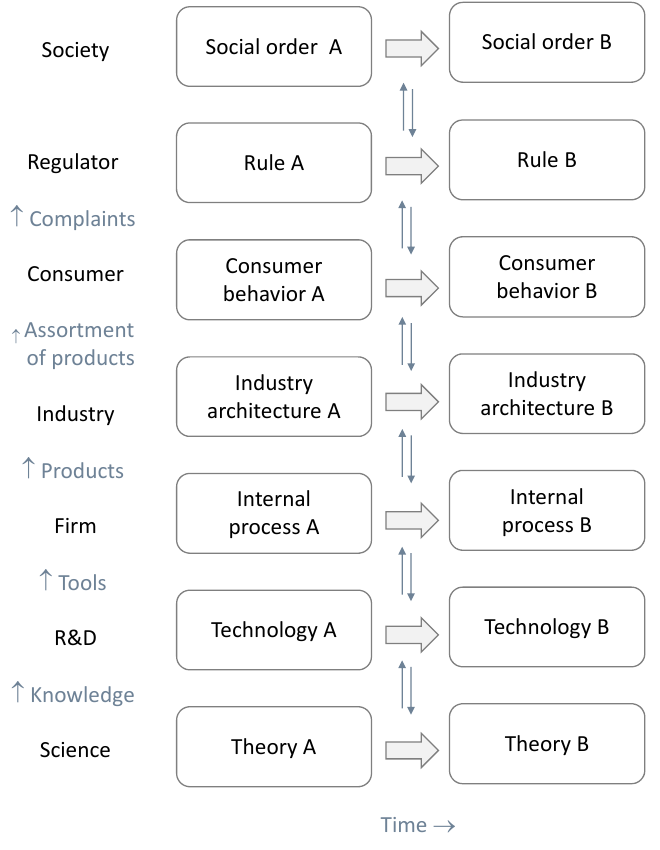
Fig. 1. The Disruption Framework (after Kilkki et al., 2017) As referred to earlier, the disruption is defined as “…an agent is disrupted when the agent has to redesign its strategy in order to survive…”. The disruption